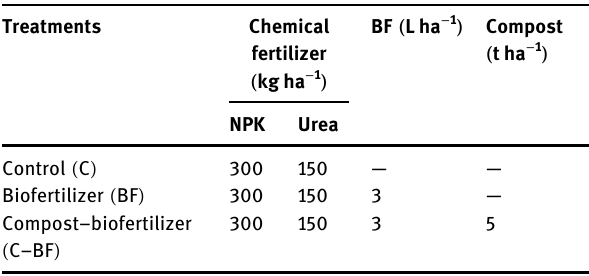
Table 1: Fertilizer treatment for lowland rice by using transplanting and broadcasting